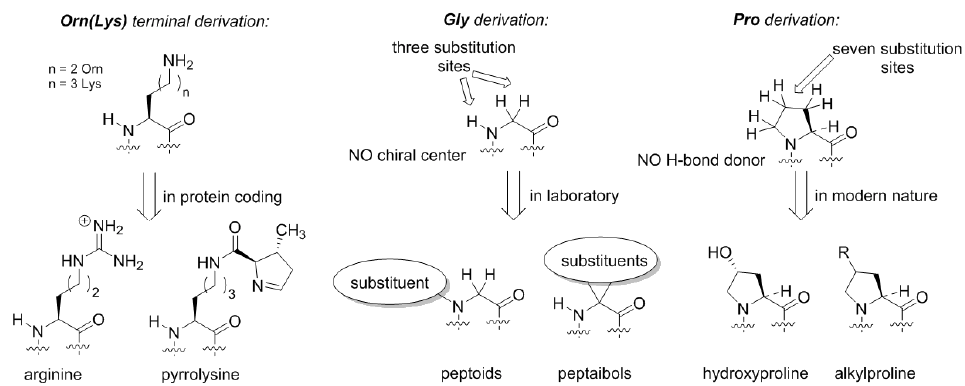
Figure 5. Some alternative backbone developments that have remaining rudiments in the existing genetic